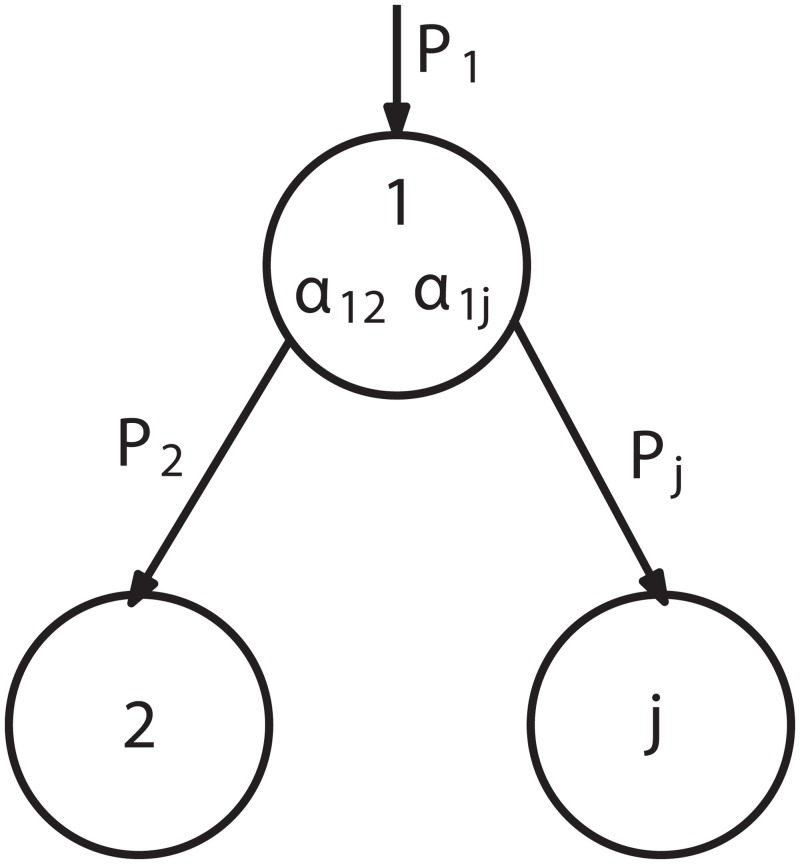
A flowrate of water through jth node.